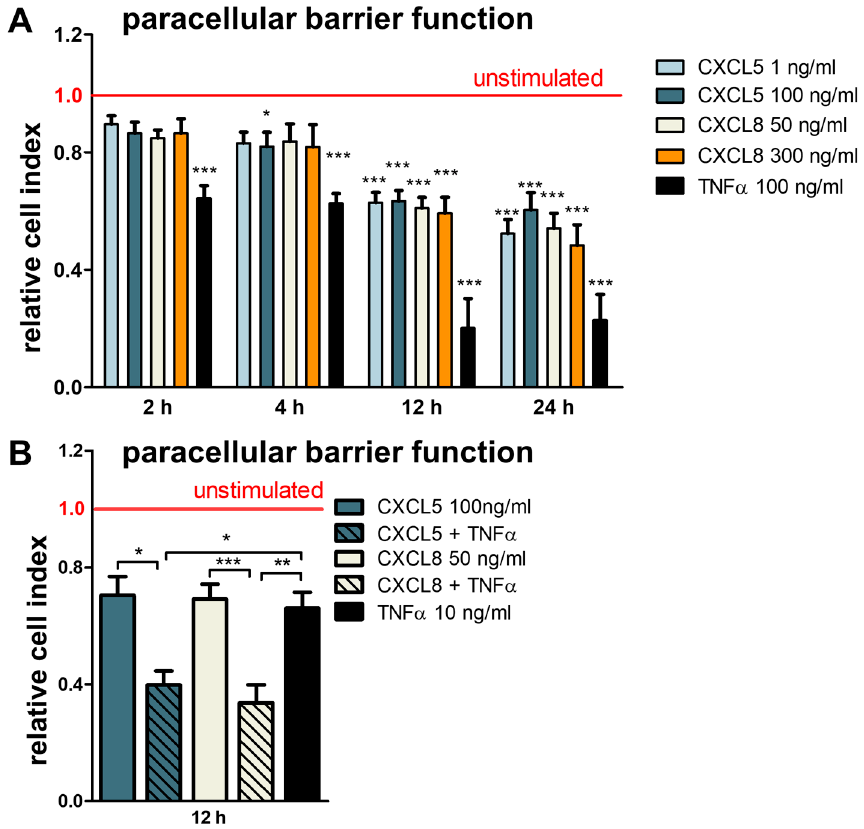
Figure 3. CXCL5 and CXCL8 decrease paracellular barrier function of brain endothelial monolayers in synergy with TNF α . ( A ) Real-time label-free assessment of the Cell Index of hCMEC/D3 using an impedance-based xCELLigence DP system. Stimulation with TNF α (100 ng/mL) served as a positive control. Data represent means and standard errors of the mean (SEM) of six independent experiments run in duplicates, tested by one-way analysis of variance (ANOVA) followed by Bonferroni post-test. ( B ) Effects of CXC chemokines with and without costimulation with TNF α (10 ng/mL) after 12 h. Synopsis of three to four independent experiments run in duplicates. Statistical testing for normal distribution by D (cid:48) Agostino–Pearson omnibus K2 test, followed by one-way ANOVA and Bonferroni post-test. Asterisks without bars indicate significance compared to unstimulated cells at the respective time points. * p < 0.05, ** p < 0.01, *** p <